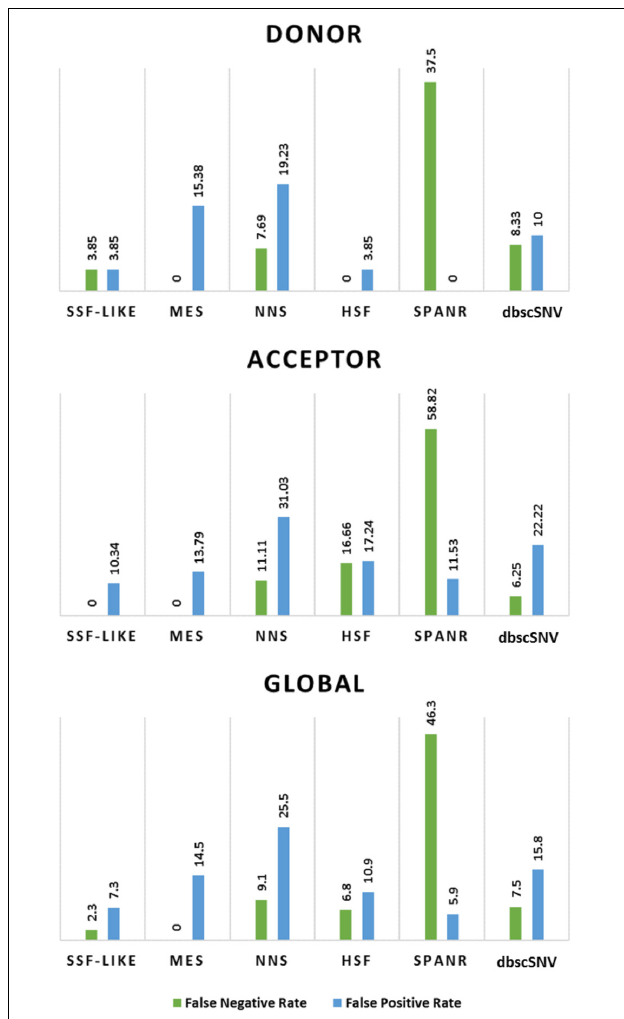
FIGURE 2 | False negative and false positive rates for individual splicing prediction tools in the discovery set . dbscSNV, database consulted for extracting the adaptive boosting and random forests scores.